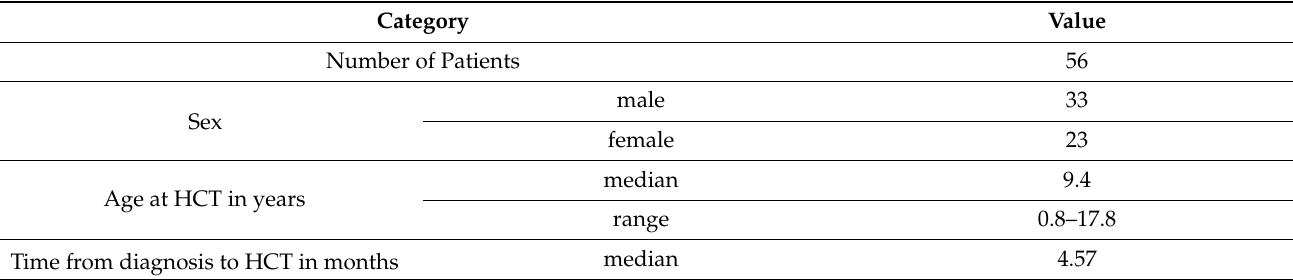
Table 1. Patient and transplantation characteristics.